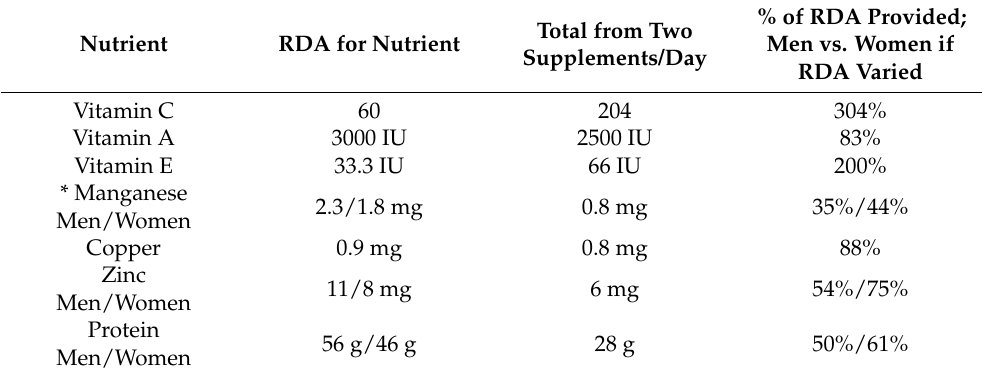
% of RDA Provided; Total from Two Men vs. Women if Supplements/Day RDA Varied